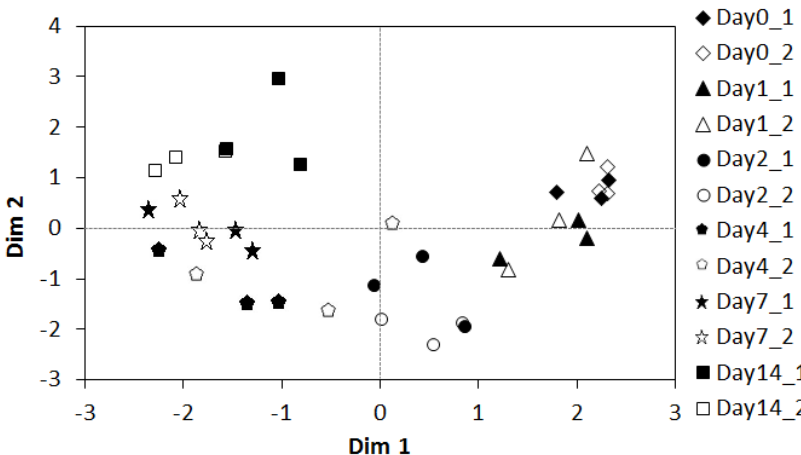
Figure 1. PCA ‐ individual factor map describing the rat cecal microbial communities following 10% cooked broccoli feeding (0–14 days) from two different rat colonies. PCA analysis was performed on each colony independently and plotted on the same graph. Dim 1 = 14.47%, Dim 2 = 7.66% for rats from Colony 217 (“1”, Indianapolis IN, closed symbols) and Dim 1 = 16.48%, Dim 2 = 8.26% for rats from Colony 208 (“2”, Fredrick MD, open symbols).